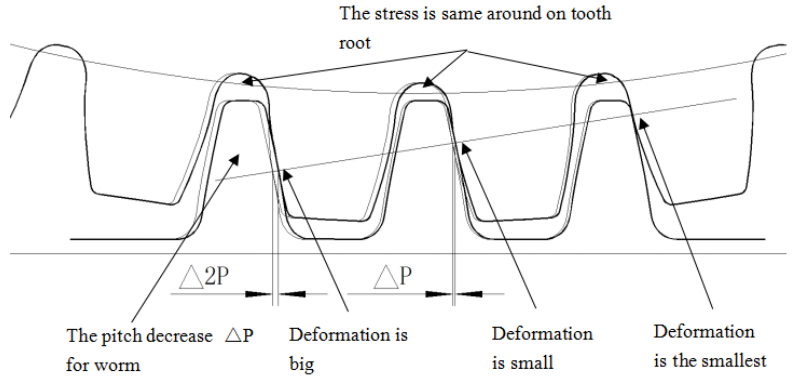
Figure 12. The distribution of stress for new meshing design between steel worm & helical gear (a > b > c).